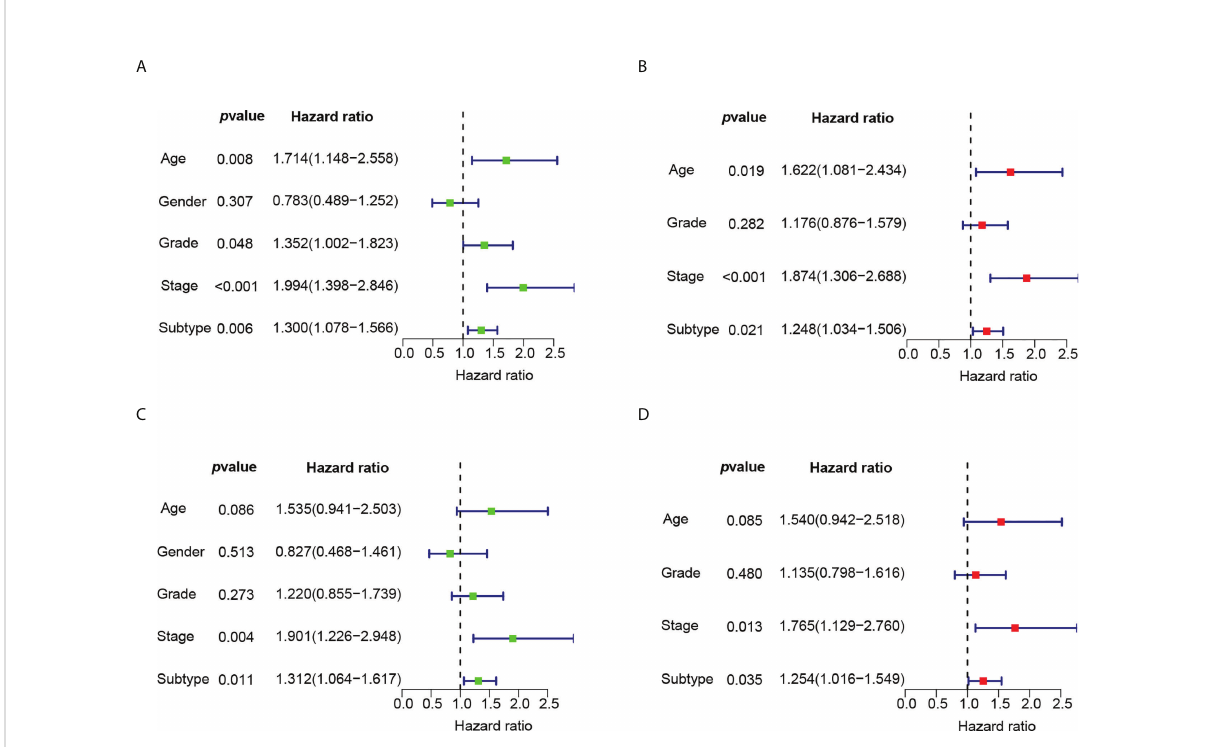
FIGURE 6 The univariate and multivariate Cox regression analyses of OS according to subtypes. (A) Univariate Cox regression analysis of OS according to subtypes in GSE53625. (B) Multivariate Cox regression analysis of OS according to subtypes in GSE53625. (C) Univariate Cox regression analysis of OS according to subtypes in GSE53624. (D) Multivariate Cox regression analysis of OS according to subtypes in